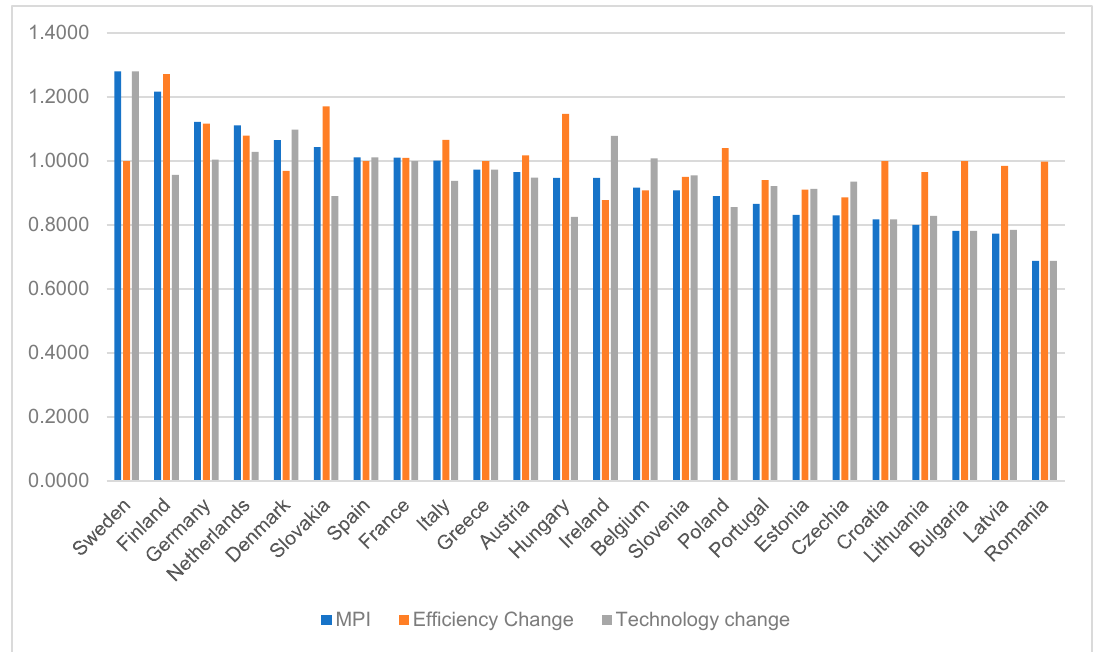
Figure 5. Changes in productivity between the years 2019 and 2013.